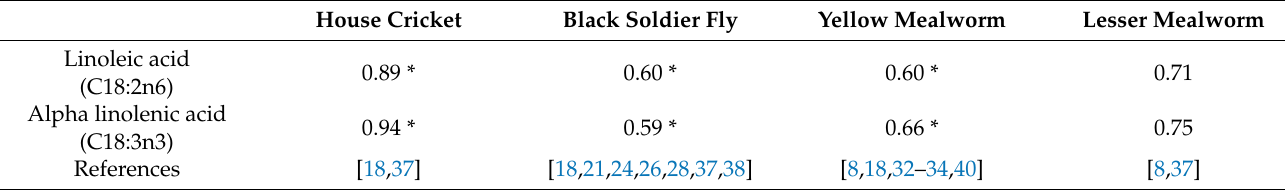
Table 3. Correlation coefficients (Spearman) between linoleic and alpha linolenic acid contents in house cricket ( Acheta domesticus ), black soldier fly ( Hermetia illucens ), yellow mealworm ( Tenebrio molitor L.) and lesser mealworm ( Alphitobius diaperinus ), and the linoleic and alpha linolenic acid contents used in the rearing